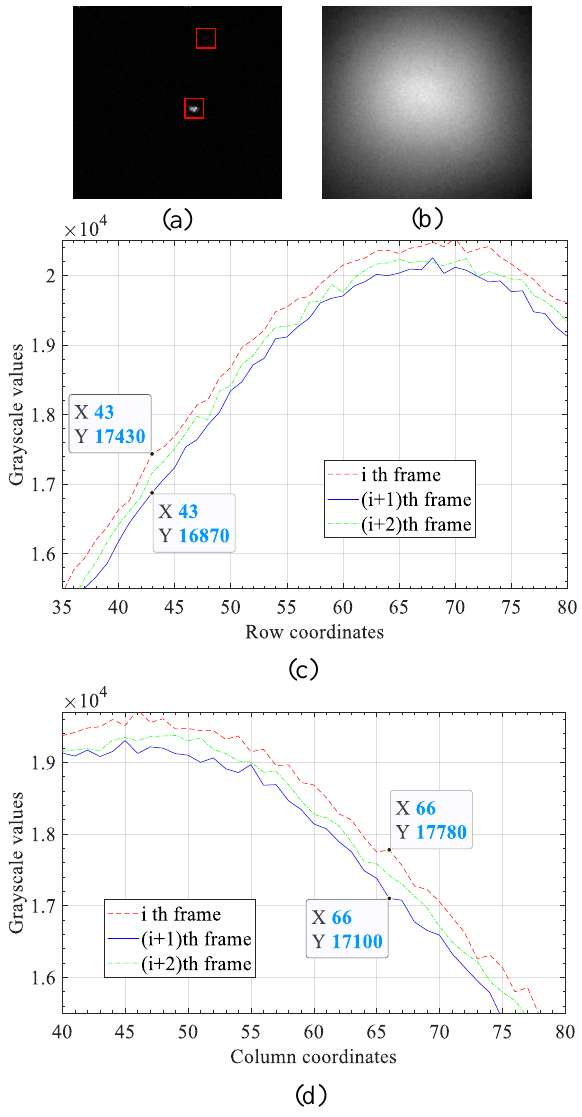
Figure 1. Analysis of vignetting characteristics. ( a ) There is no obvious vignetting on the image. ( b ) There is obvious vignetting on the image. ( c ) The curves of the summation of row pixel grayscale values of three random successive frames. ( d ) The curves of the summation of column pixel grayscale values of three random successive frames.